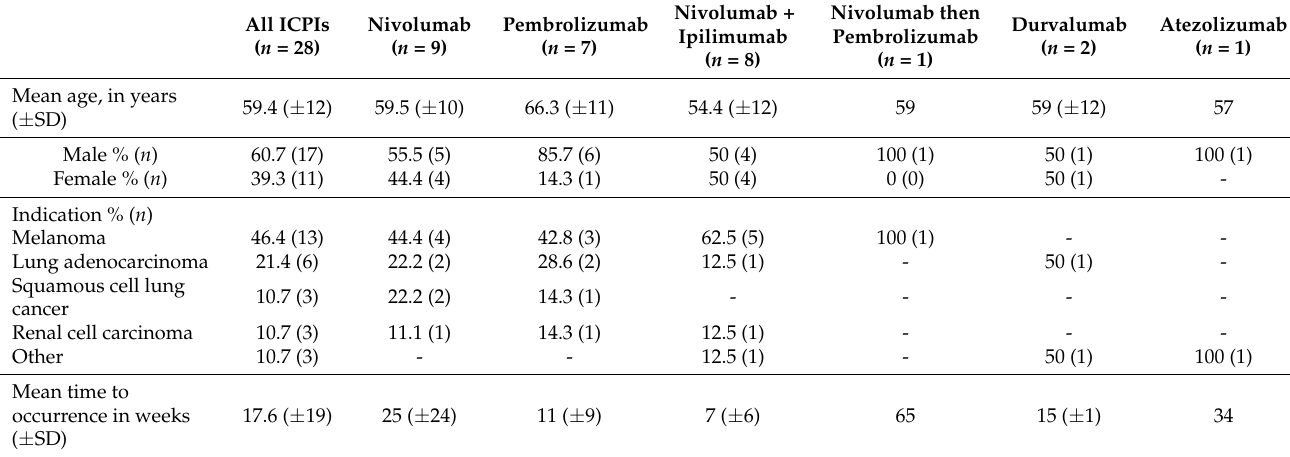
Table 1. Characteristics of patients with ICPI-induced ocular